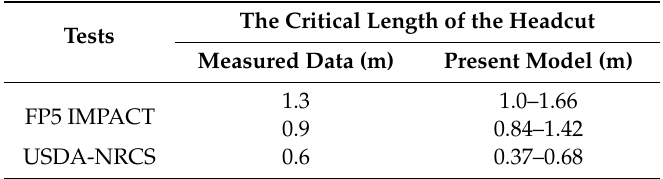
Table 4. Comparisons of the critical length of the headcut with experimental data and the present